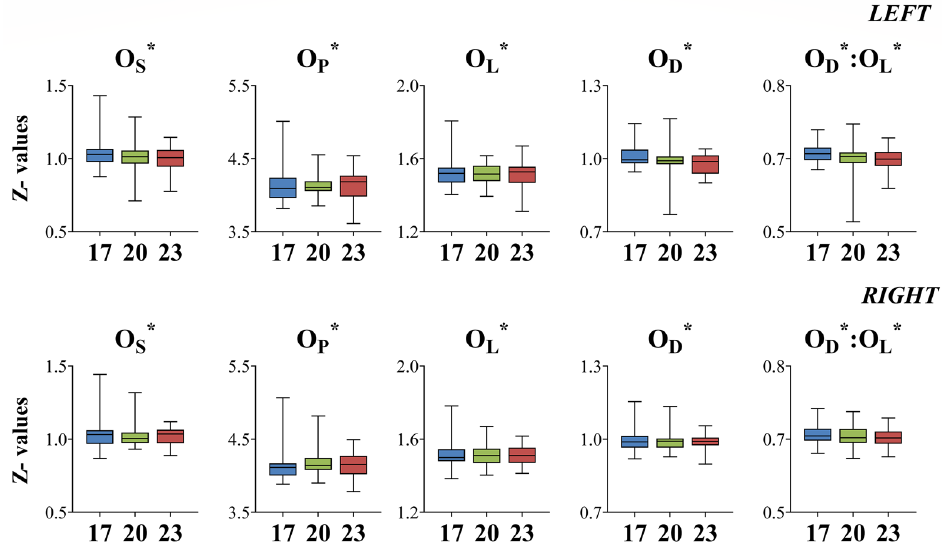
Figure 8. Box plots (—, median; (cid:3) , 25 and 75% percentiles; I, highest and lowest values) of standard- ized univariate morphological descriptors (Z-values) for seabream early juveniles taken at 93–95 dph (days post-hatching); 17, 20, and 23: fish initially reared at 17, 20, and 23 ◦ C DT (developmental temperature), respectively. O L : maximum otolith length, O D : maximum otolith depth , O S : otolith surface area, O P : otolith